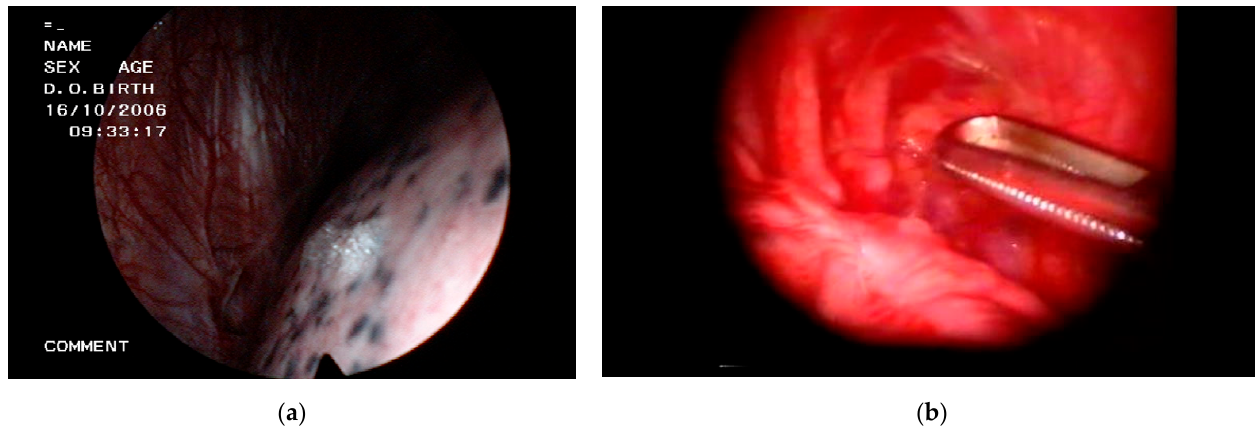
Figure 2. Thoracoscopic views in spontaneous pneumothorax. ( a ) Apical bleb; ( b ) Bleblectomy using an endostapler.